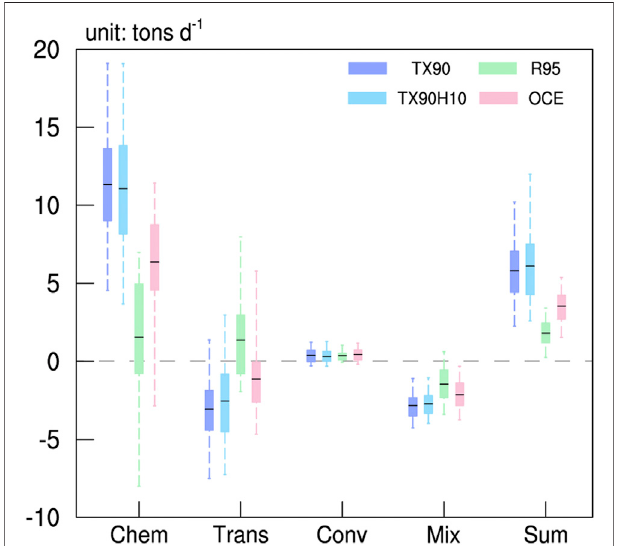
FIGURE 3 | Mass fl uxes of ozone (units: tons d − 1 ) simulated by the GEOS-Chem corresponding to TX90, TX90H10, R95, and OCE during the summers of 2015 – 2021 in East of China. The boxplots showed the 25th percentile and 75th percentile and medians. The x -axis indicates the physicochemical processes: chemistry, transport, convection, mixing and their sum within the planetary boundary layer.